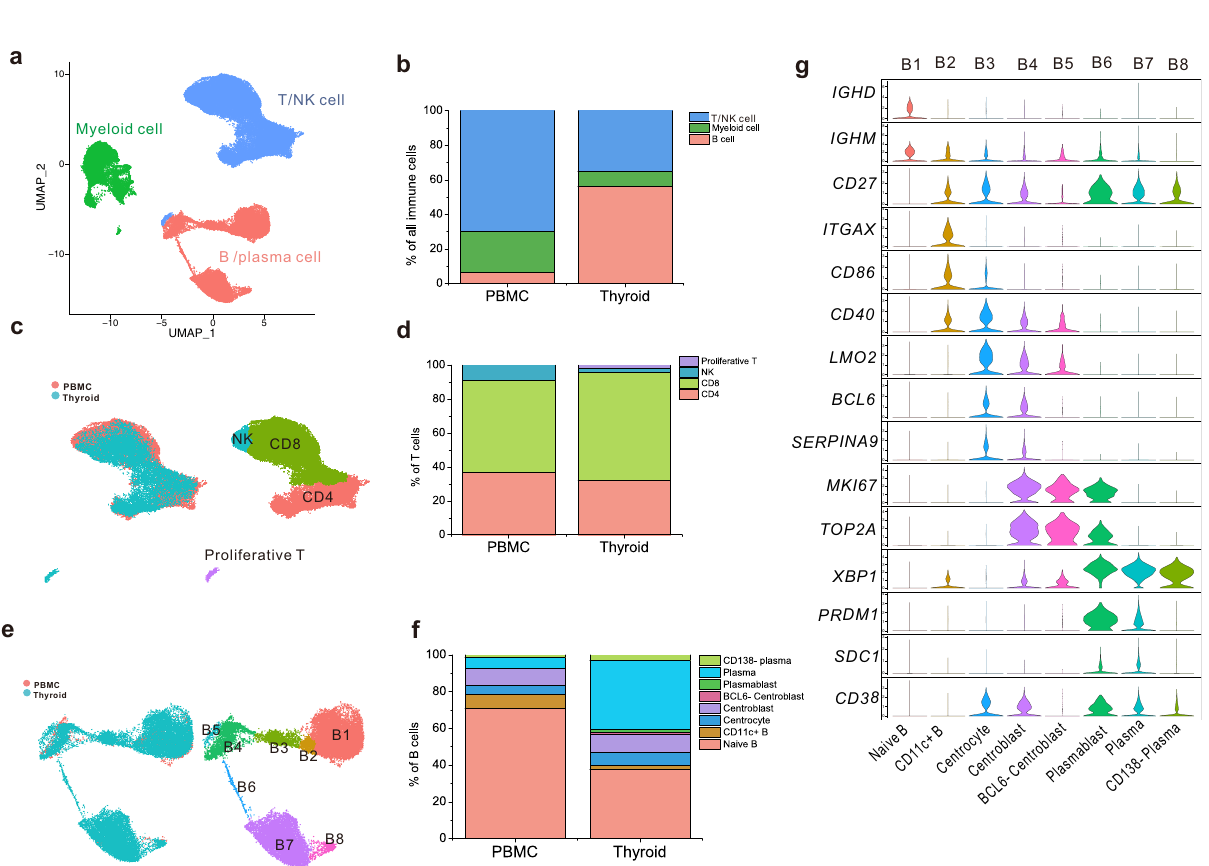
Fig. 6 ACKR1 + endothelial cells and CCL21 + fi broblasts or myo fi broblasts are few in thyroid tissues of non-HT controls compared with HT patients. a – d CCL21 + fi broblasts or myo fi broblasts are signi fi cantly increased in thyroid tissues of HT patients compared with non-HT controls. In situ hybridization combined with polychromatic immuno fl uorescence staining shows FSP1 + CCL21 + fi broblasts or myo fi broblasts are easily observed in germinal centers ( a ), area of lymphocyte aggregates ( c ) or adventitia of vessels ( c , white arrows), as well as the area of intact thyroid follicular structures with few lymphocytic in fi ltration ( b ) of the thyroid tissues of HT patients. While in thyroid tissues of non-HT controls, fi broblasts are rarely and CCL21 + cells are barely not observed (d). FSP1 is the name for fi broblast-speci fi c protein 1. Panel b is magni fi ed image of the area of rectangular box in ( a ). e - f HEVs are not observed and ACKR1 + vessels are signi fi cantly decreased in thyroid tissues of non-HT controls. Total number of vessels and ACKR1 + vessels ( g ), and the rate of ACKR1 + vessels ( h ) in thyroid tissues of non-HT controls are signi fi cantly less than that of in HT patients. 4 vs 4, 3 – 5 regions in each of the 3 different slices for each sample are stained and quanti fi ed. Two-sided Student ’ s t test. The error bars indicate SD.